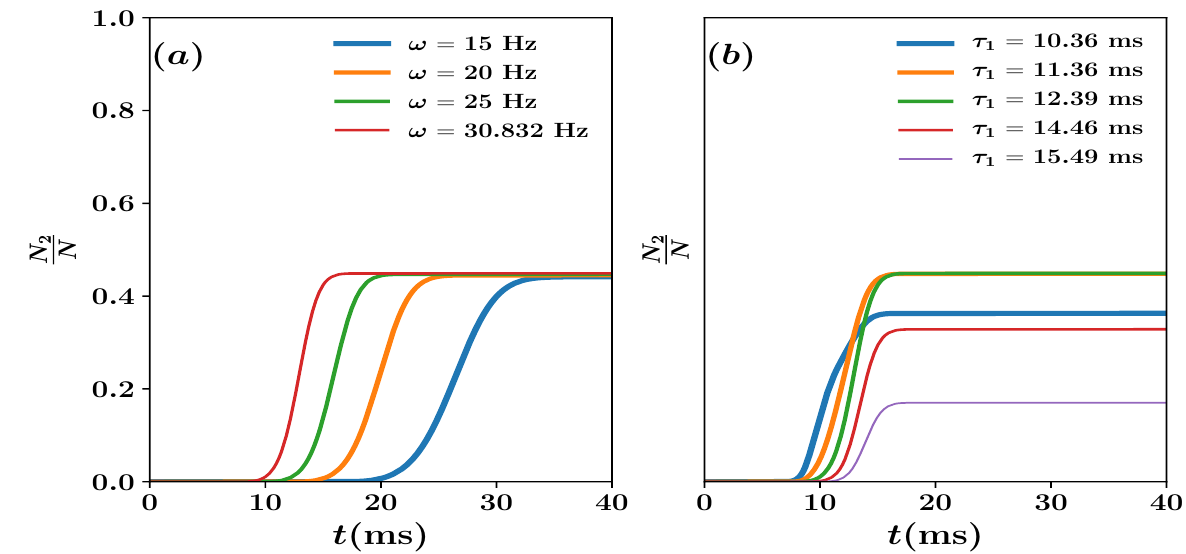
Figure A1. (Color online) Time evolution of the fraction of particle number transferred to the BEC Ψ 2 for ( a ) various trapping frequencies ω and ( b ) various peak positions of the ( τ 1 ) of the pump laser pulse. A LG-G pulse sequence is used to trigger the dynamics in the weak light–matter interaction regime characterized by V max = 1. While studying the effect of the trapping frequencies [( a )], τ 2 and τ 1 are fixed at 10.33 ms and 13.43 ms, respectively. On the other, the rapping frequency ω = 2 π × 30.832 Hz and peak position τ 2 = 10.33 of stokes pulse are kept fixed when studying the variation of τ 1 [ ( b ) ]. The total number of particles in the system is N = 10 4 , and the intra-and interspecies interactions are a 11 = 99 a 0 , a 22 = 95.44 a 0 and a 12 = 80 a 0